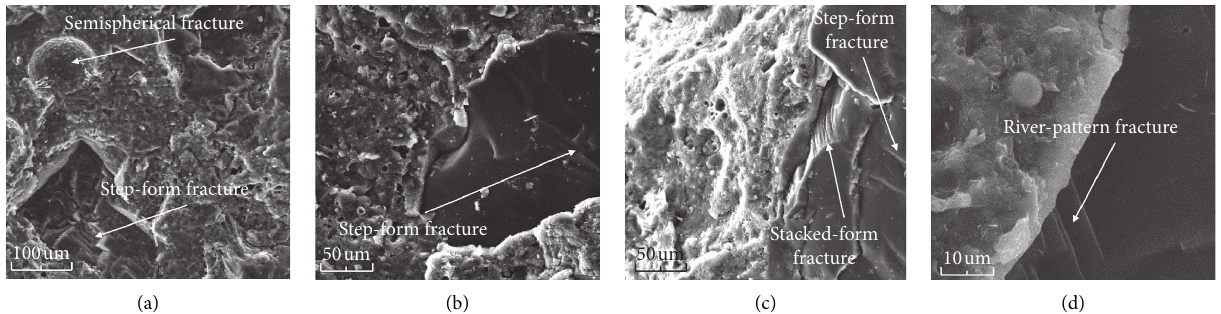
Figure 13: SEM images of the fracture morphologies of concrete with fly ash replacement ratios of (a) 0, (b) 20, (c) 35, and (d) 50